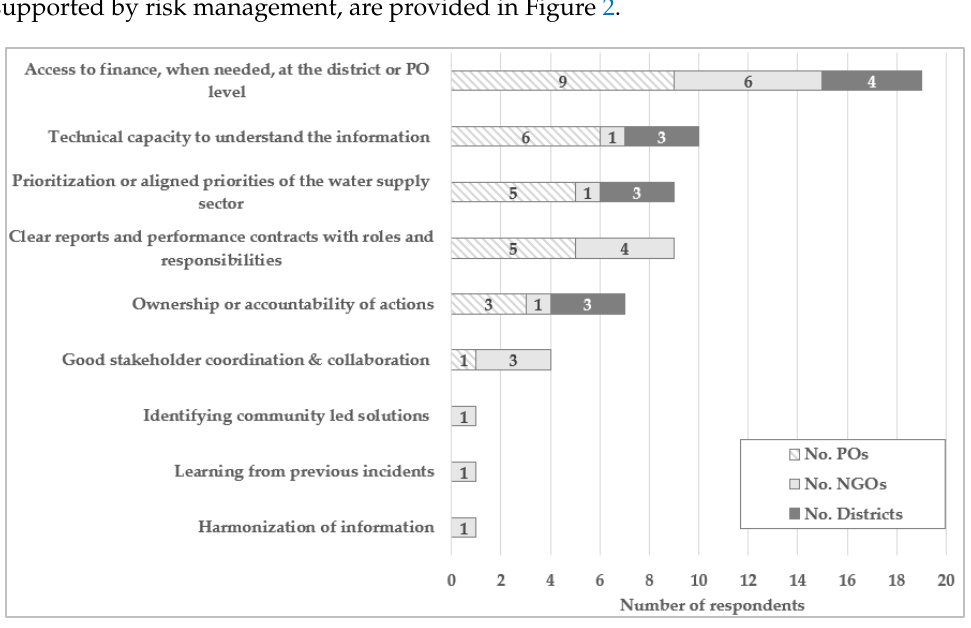
Figure 2. Factors respondents highlighted as critical for improvement action which could be sup- ported by WSP implementation. PO — private operator, NGO — non-governmental organization.